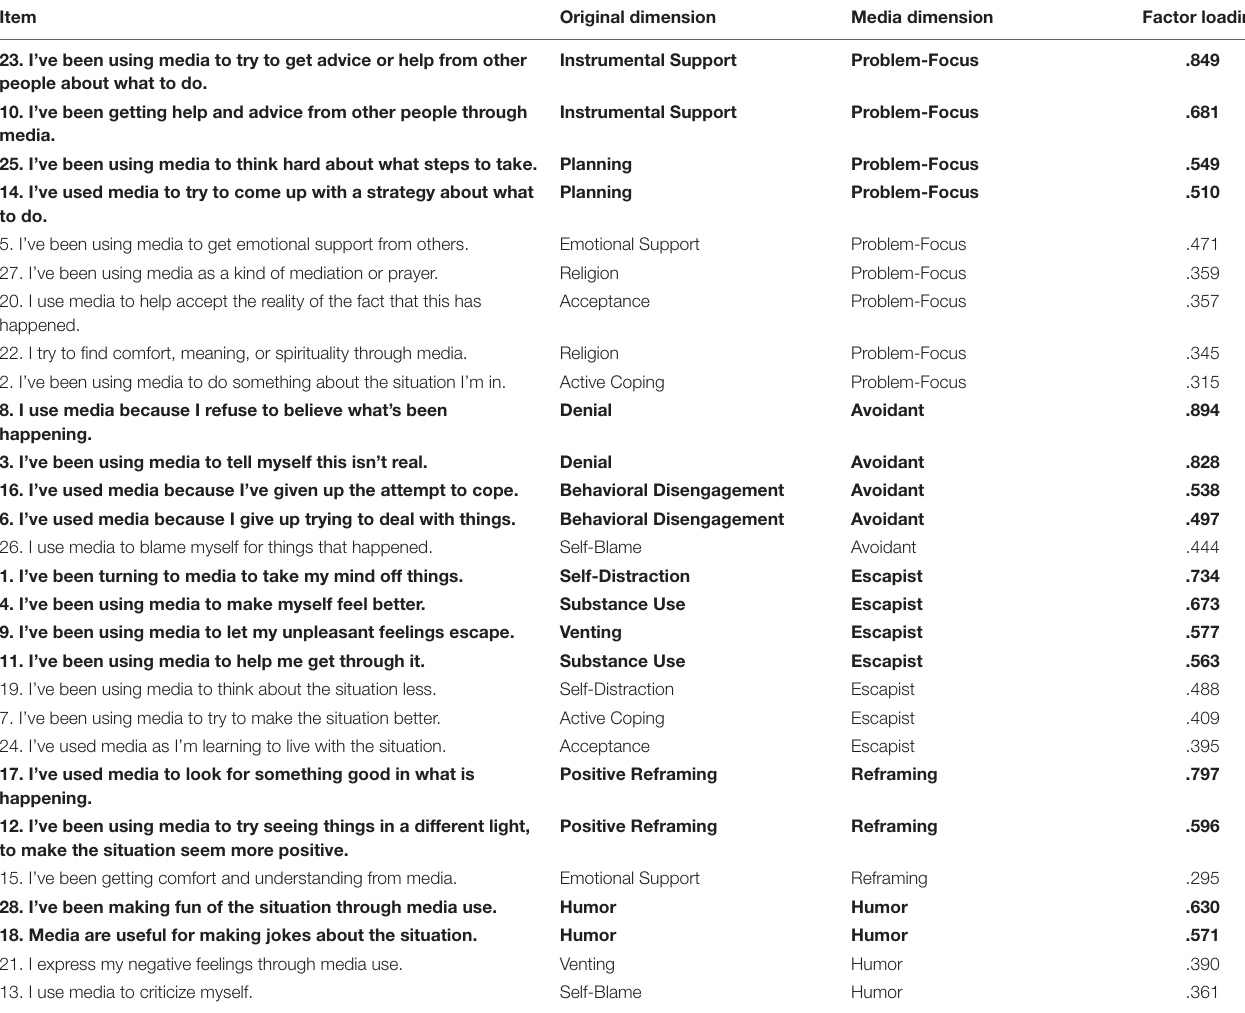
TABLE 2 | Exploratory factor analysis for media coping.